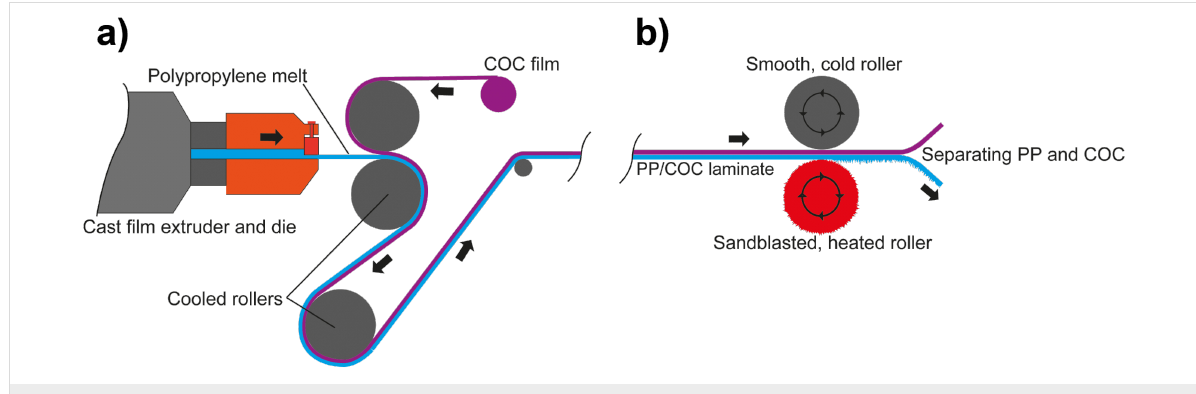
Figure 1: Schematic showing the roll-to-roll fabriction of a thin nanofur film by the example of PP and COC. (a) Coextrusion of PP on the COC support layer. The PP is extruded through a cast film die and laminated onto a previously extruded COC film in the calender. The PP and COC films stick strongly together but do not mix. (b) Hot pulling of nanofur from the PP film with a sandblasted roller. The COC film serves as a support layer keeping the PP from melting completely and thus enables transport through the calender. The gap size is set slightly below the nominal film thickness so that the films experience minimal embossing forces. Temperature of the sandblasted roller is set slightly above the melting temperature of the polymer. Finaly, the structured PP and the sacrificial support layer of COC can easily be separated in a peeling